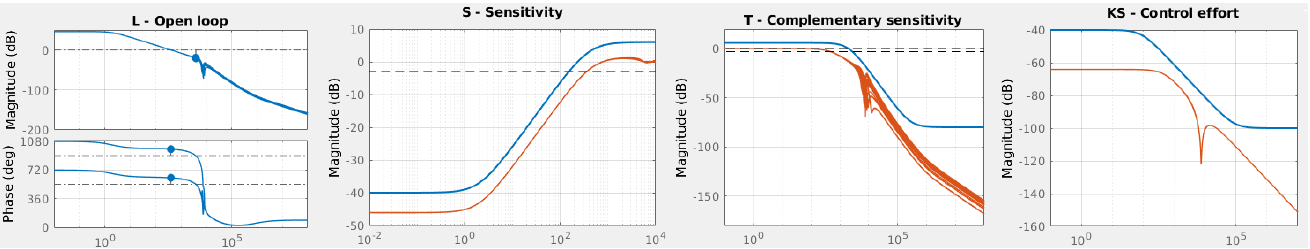
Figure 10. SEPIC open loop plant family with S , T , and KS functions using the reduced-order controller, which retains all imposed performance specifications for all test cases, provides high phase and gain margins, and guarantees closed loop response practically similar to that of a first-order low-pass filter; a relatively low bandwidth was imposed to compensate the SEPIC converter resonance and presence of multiple nonminimum phase